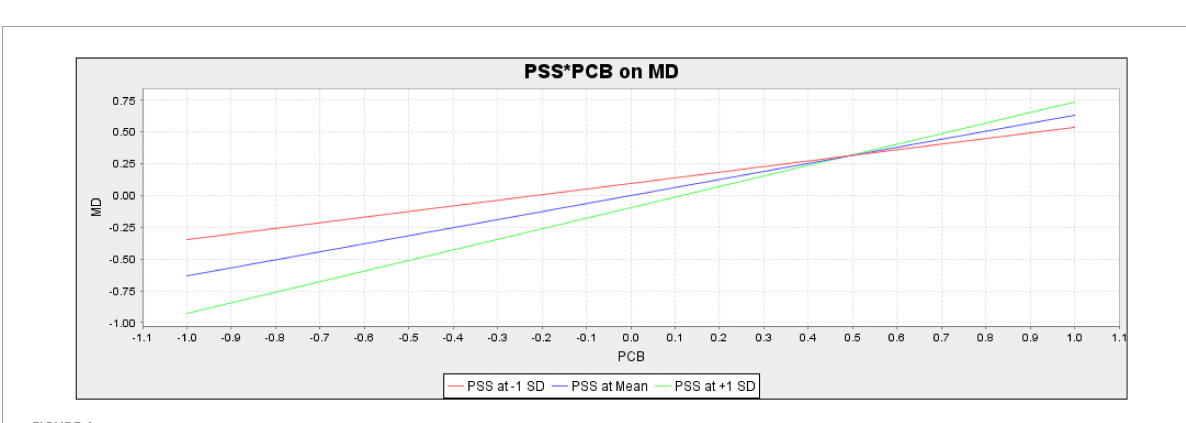
FIGURE4 Slope for perceived supervisor support (PSS) and psychological contract breach (PCB) on moral disengagement (MD)